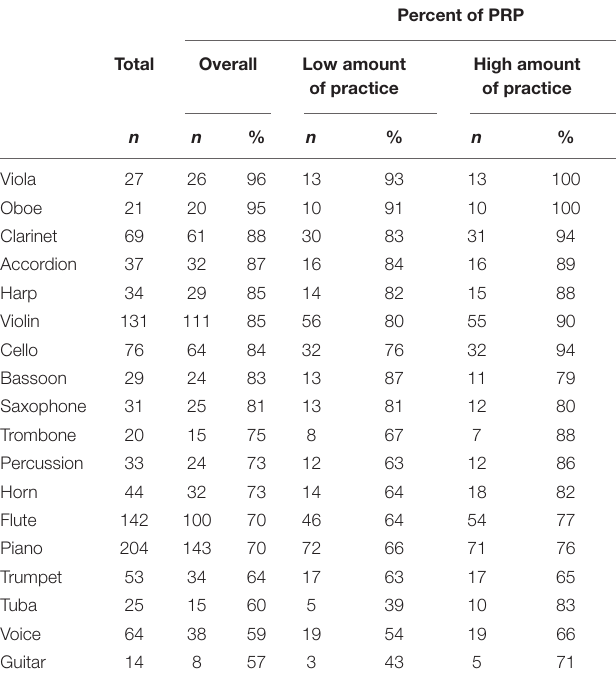
TABLE 4 | Prevalence of PRP for different instruments and practicing efforts.